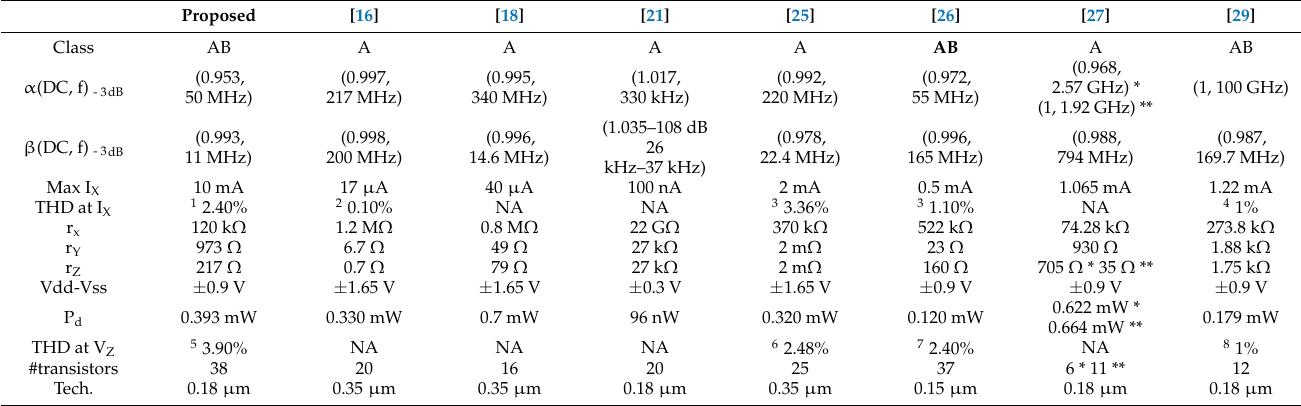
Table 6. Comparison between proposed circuit and some other previously reported VCII topologies.